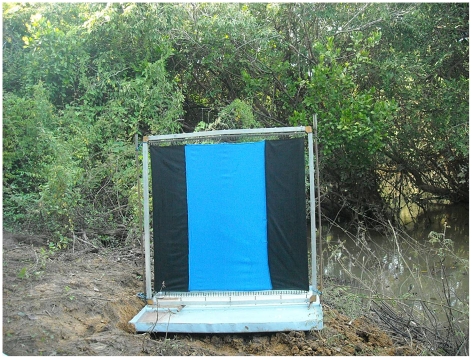
The standard 1 m×1 m Black Blue Black e-target (treatment A) set up on a tray.